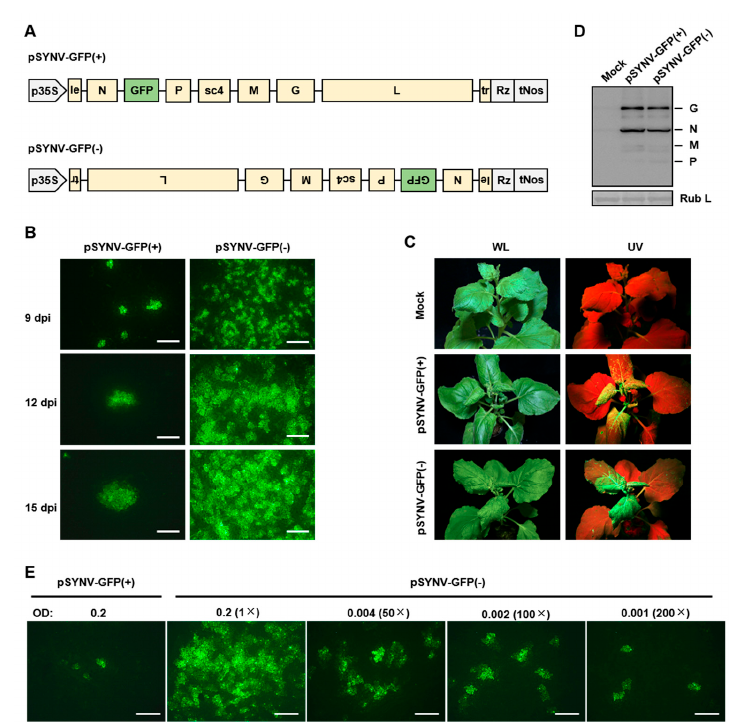
Figure 2. A genome ‐ sense RNA approach drastically increased recombinant SYNV recovery. ( A ) Figure 2. A genome-sense RNA approach drastically increased recombinant SYNV recovery. ( A ) Schematic Schematic representation of the pSYNV ‐ GFP(+) and pSYNV ‐ GFP( ‐ ) plasmids for transcription of the representation of the pSYNV-GFP( + ) and pSYNV-GFP(-) plasmids for transcription of the SYNV agRNA SYNV agRNA and gRNA derivatives containing an engineered GFP expression cassette. p35S, and gRNA derivatives containing an engineered GFP expression cassette. p35S, cauliflower mosaic virus doubled 35S promoter; le, leader; tr, trailer; Rz, hepatitis delta virus antigenomic ribozyme; tNos, Nos terminator. ( B ) GFP foci in N. benthamiana leaves infiltrated with agrobacterial mixtures harboring the pSYNV-GFP( + ) or pSYNV-GFP(-), along with supporting plasmids designed for expression of SYNV core proteins and viral suppressors of RNA silencing. Infiltrated leaves were photographed at 9, 12, 15 days post infiltration (dpi) with a fluorescence microscope. ( C ) Symptoms elicited by